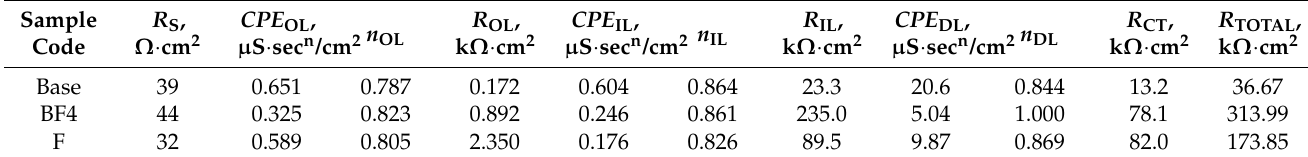
Table 9. Equivalent circuit parameters obtained from the fitting of the EIS experimental data for the PEO-treated